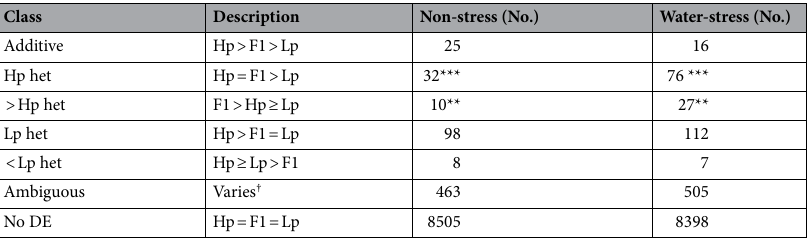
Table 2. Hybrid performance. Each number corresponds to the number of transcript isoforms in each heterosis category under non- and water-stress conditions. † e.g. Hp > Lp, Hp = F1 = Lp; Hp > F1, Hp = F1 = Lp. Asterisks indicate binomial exact test (against the null hypothesis of equal proportion) significance level: (**) P < 0.01; (***) P <